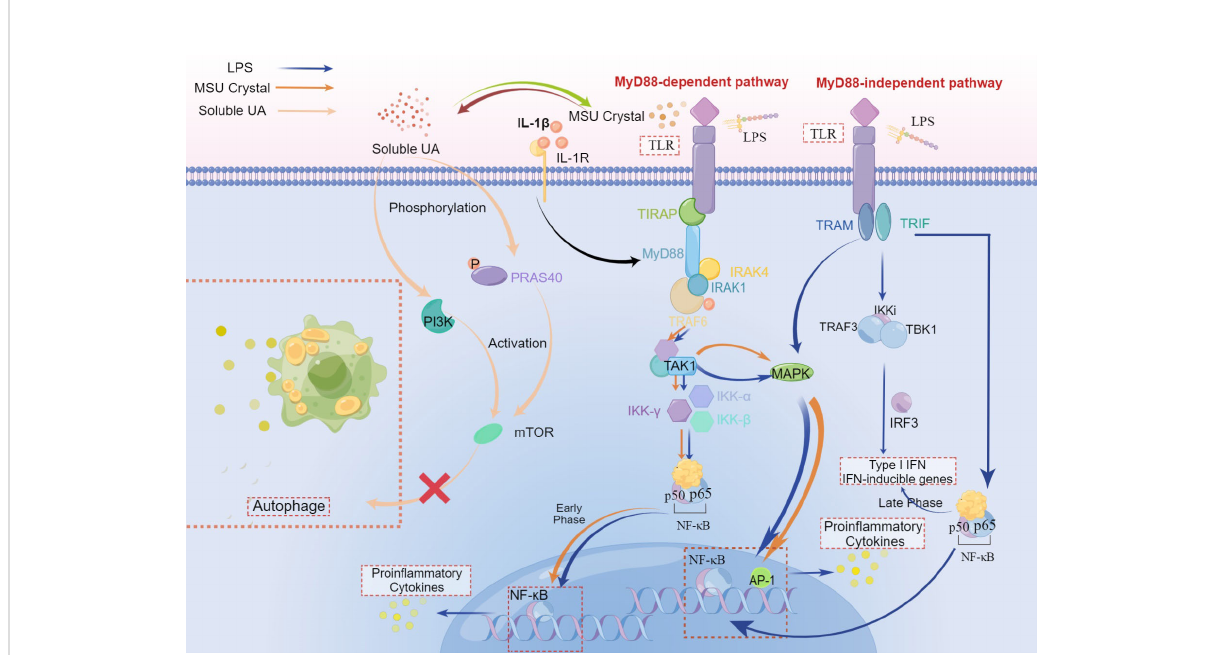
FIGURE 3 The crosstalk of LPS, MSU crystal, and soluble UA in immune-in fl ammatory signal pathway. Both MSU crystal and LPS could activate TLRs to recruit TIRAP and MyD88. The stimulation of MyD88 molecule by ligands primes the interaction of MyD88 and IRAK-4, which allows IRAK-1